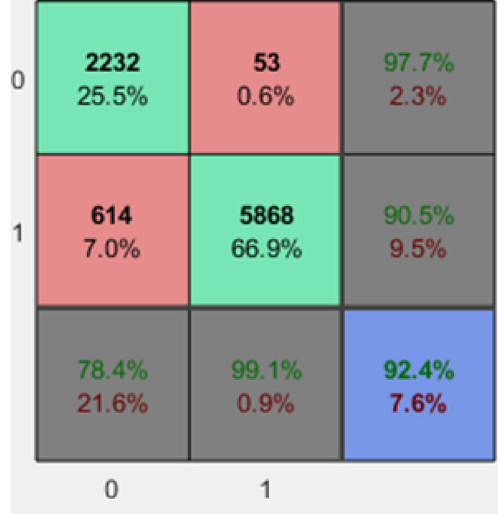
Table 12 Confusion matrix of autoencoder with BPN on UNSW- NB15